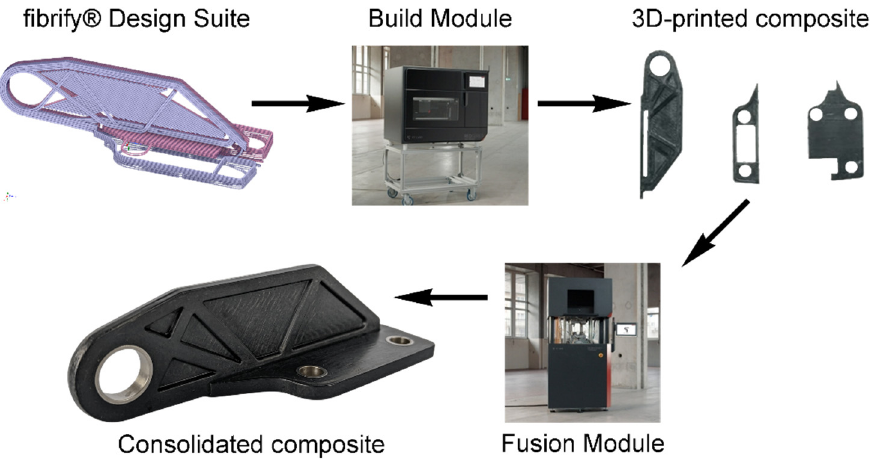
Figure 1. 9T Labs’ production cycle of the composite part.